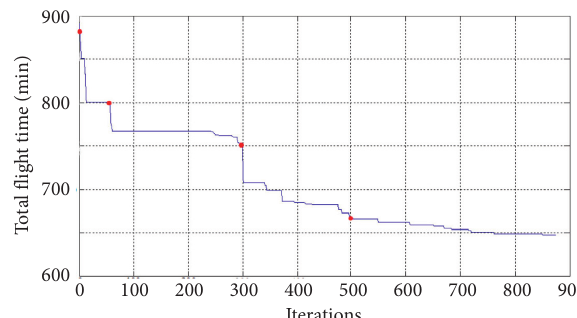
Figure 15: SA algorithm training process.